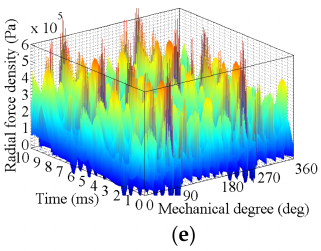
Figure 8. Radial force density in the IPMSM with stator deformation at high-speed load condition.